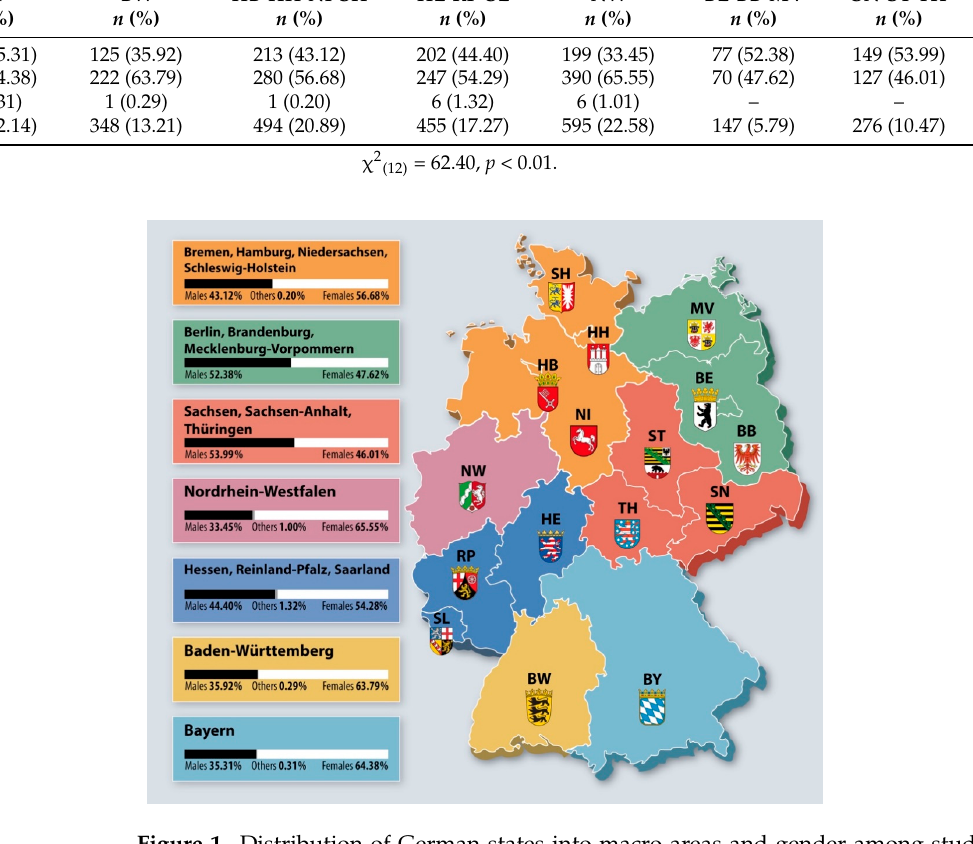
Figure 1. Distribution of German states into macro-areas and gender among study participants ( n = 2635). Table 2. Weekly workload reduction during the lockdown period among the German macro areas ranked by Gross National Product